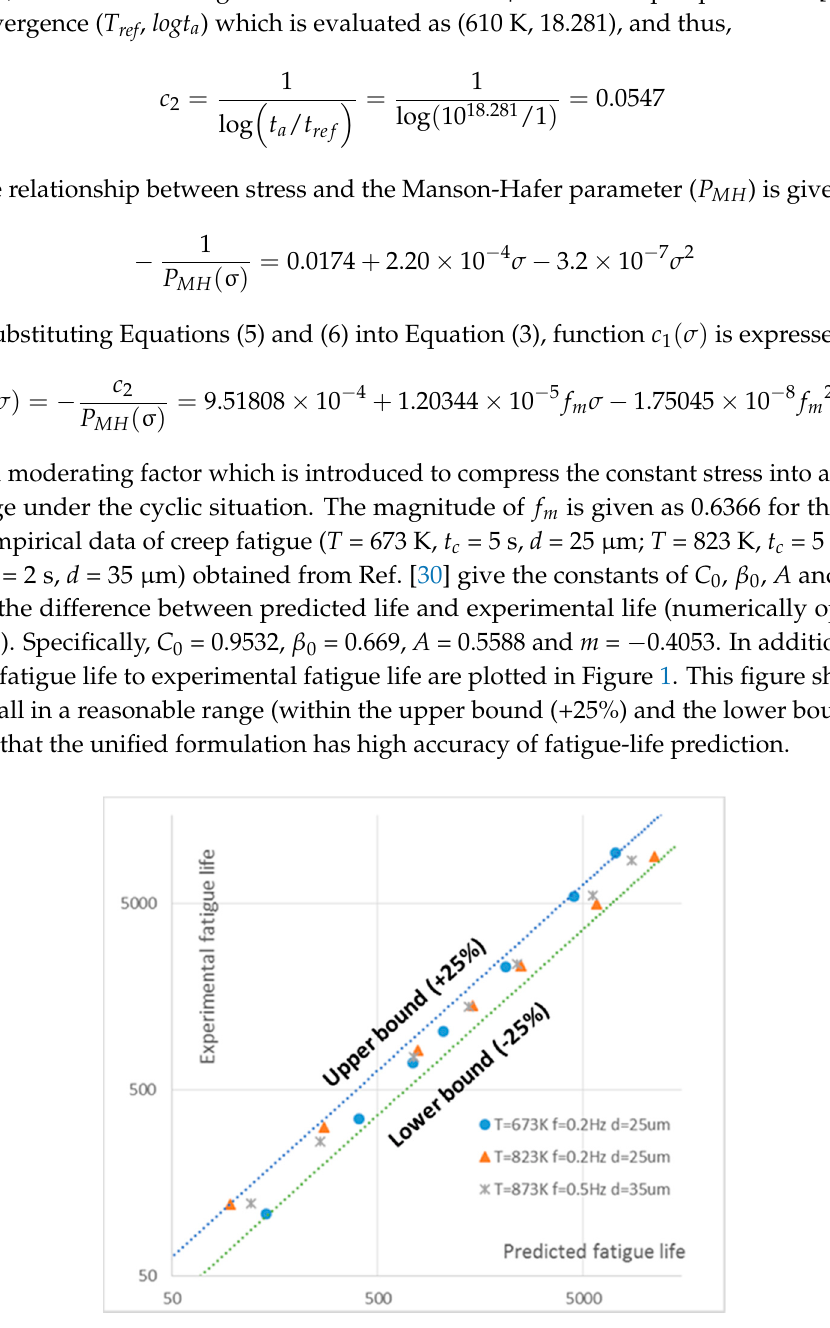
Figure 1. Application of the unified model to predict fatigue life vs. experimental fatigue life for GP91 casting steel, with raw data from physical tests from